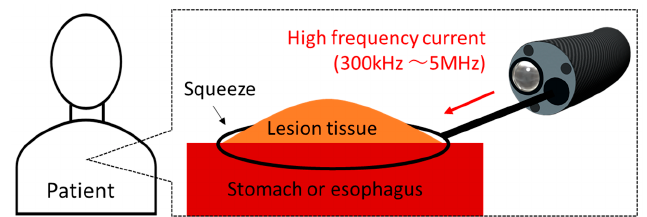
Figure 1. Schematic diagram of endoscopic mucosal resection (EMR).